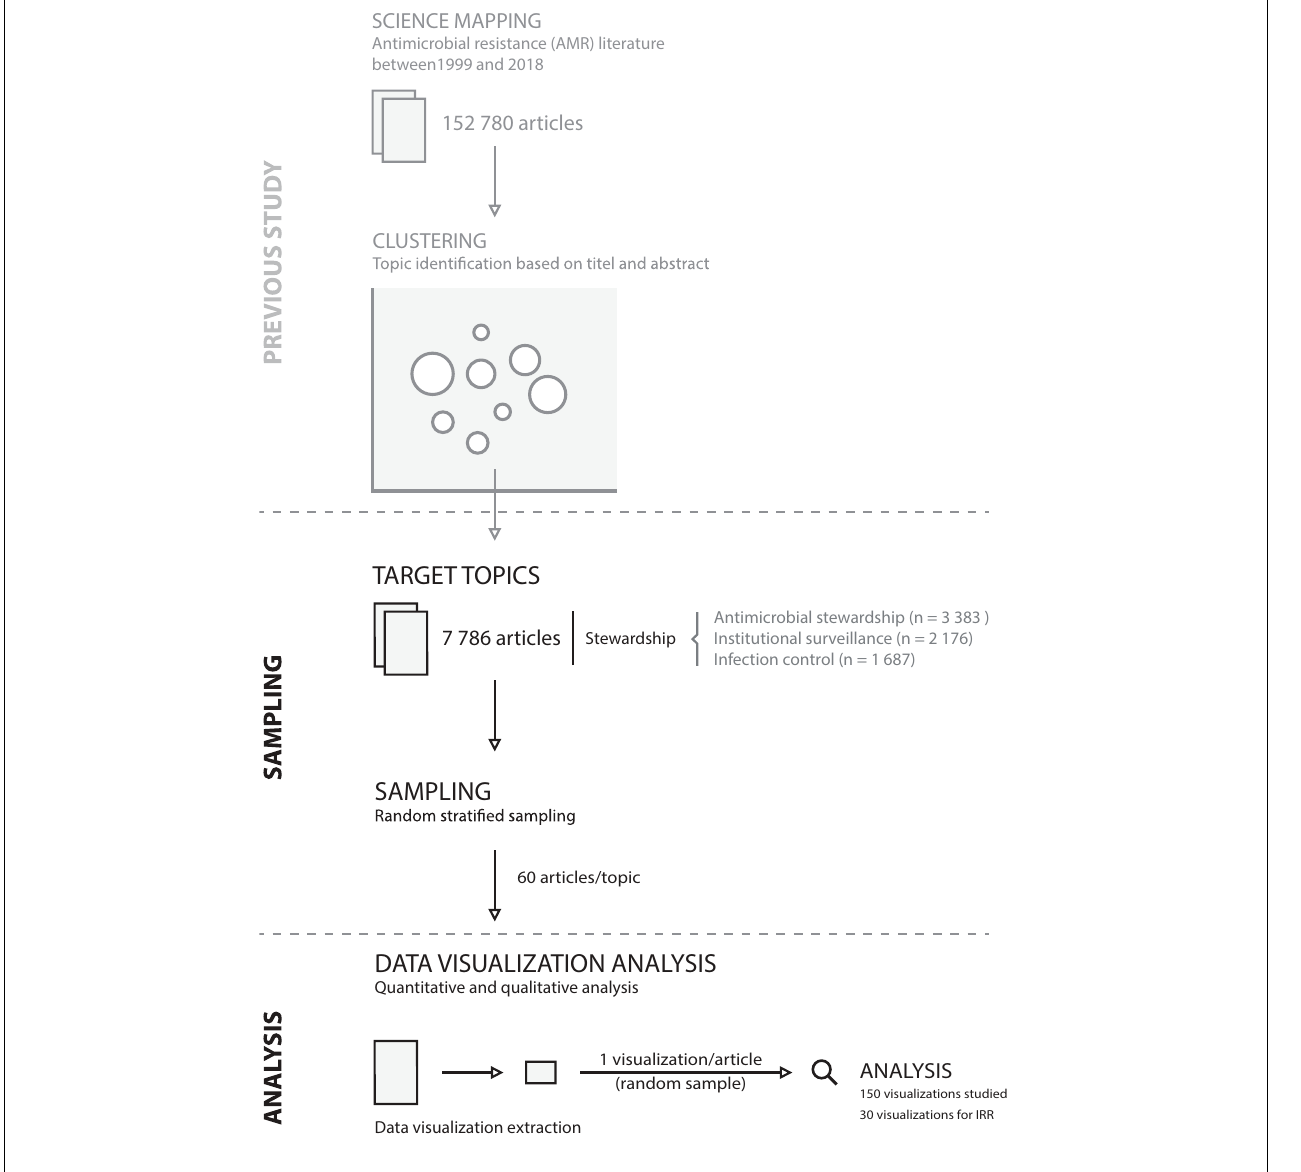
FIGURE 2 | Study design. IRR, inter-rater